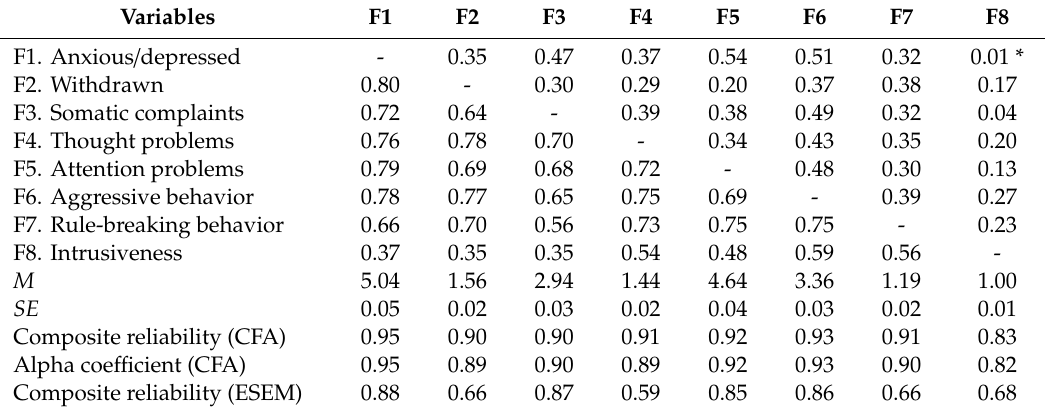
Table 3. Descriptive statistics, and latent factor correlations and composite reliability for the CFA and ESEM